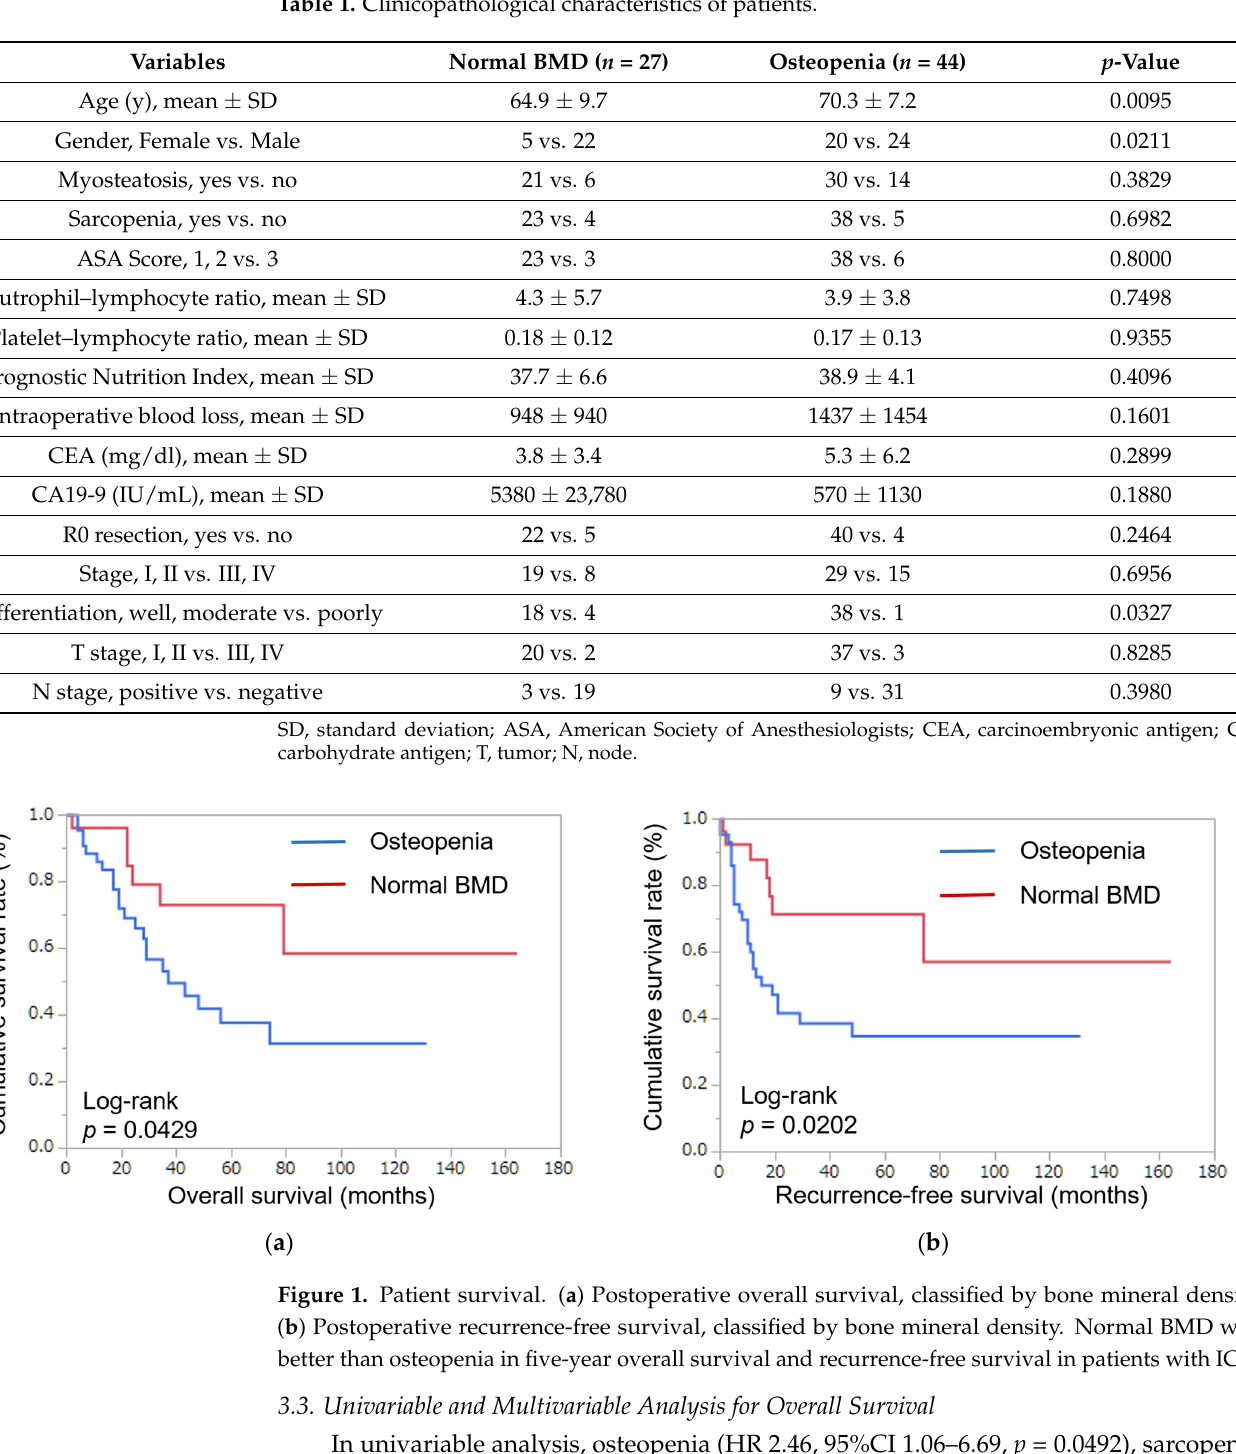
Table 1. Clinicopathological characteristics of patients.